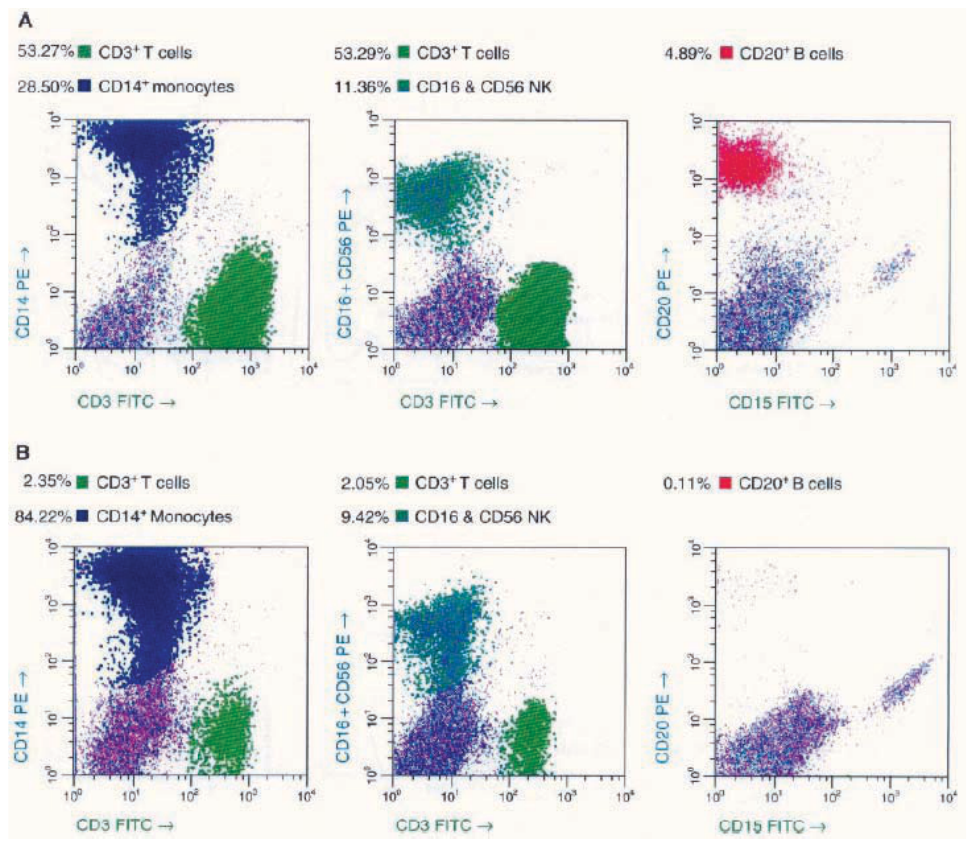
Figure 4. Transfection efficacy of mRNA demonstrated by utilized EGFP mRNA (lower part) compared to non-transfected DC (upper part). Left panels are density plots indicating large cell population gated. Middle panels are density plots showing the viability of cells (non- transfected and EGFP mRNA transfected by application of propidium iodide PI stating FL3). Right panels are histogram plots showing GFP signal in living cells. The green fluorescence intensity is increased about 100-fold in transfected cells than in non-transfected